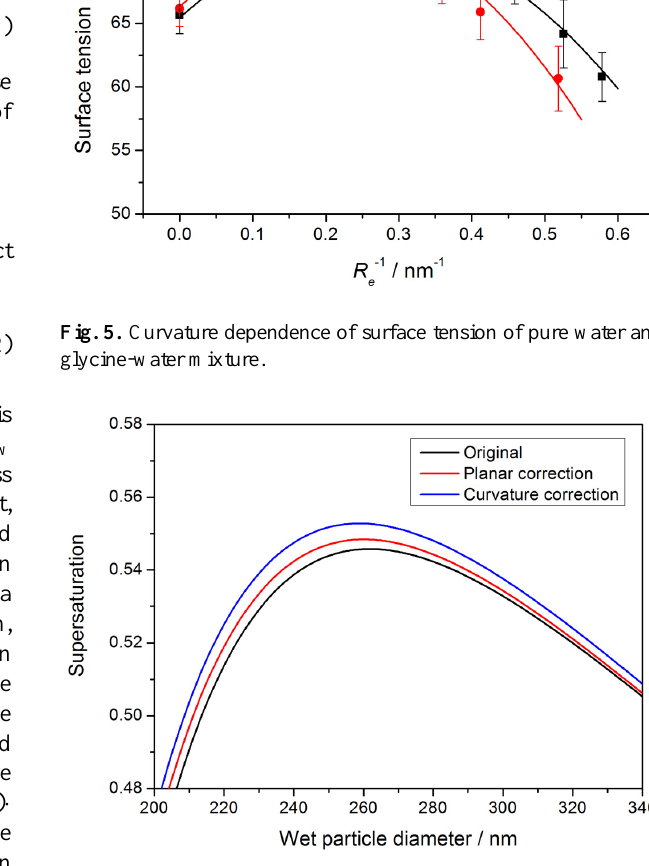
Fig. 6. K¨ohler curves for glycine (dry particle diameter=50nm) without and with surface tension